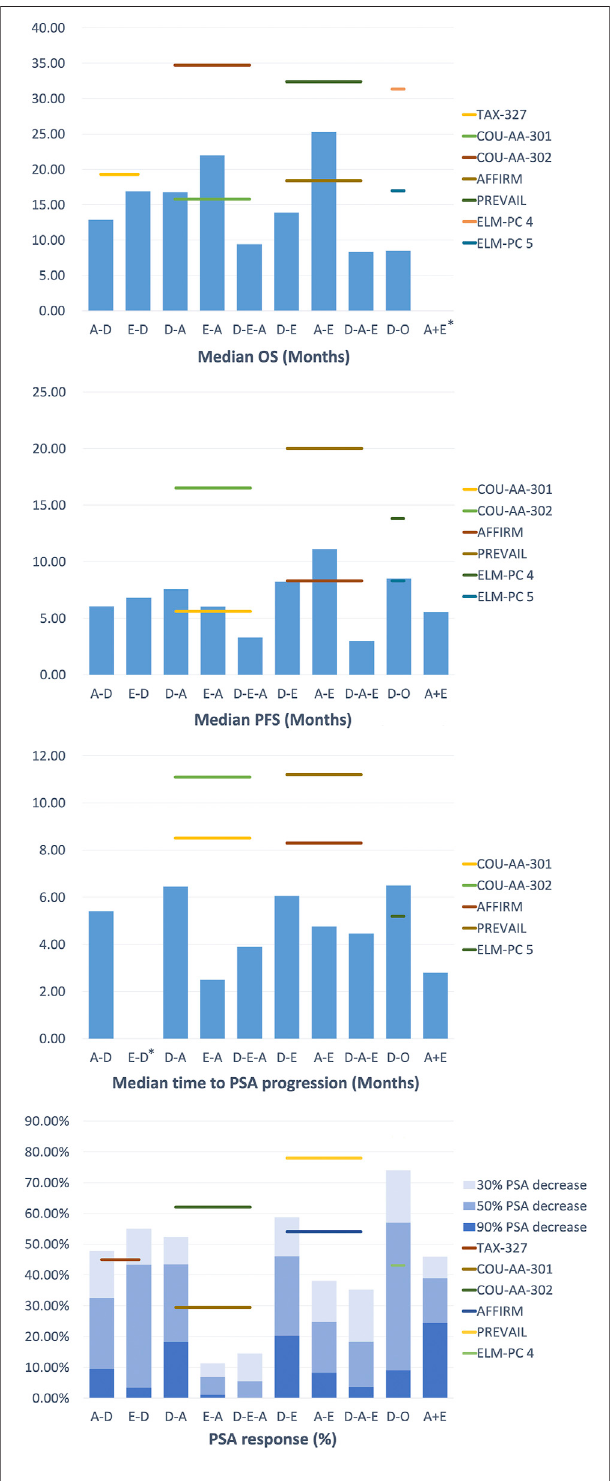
FIGURE 2 | Clinical Outcomes of treatment strategy in Metastatic Castration-Resistant Prostate Cancer.